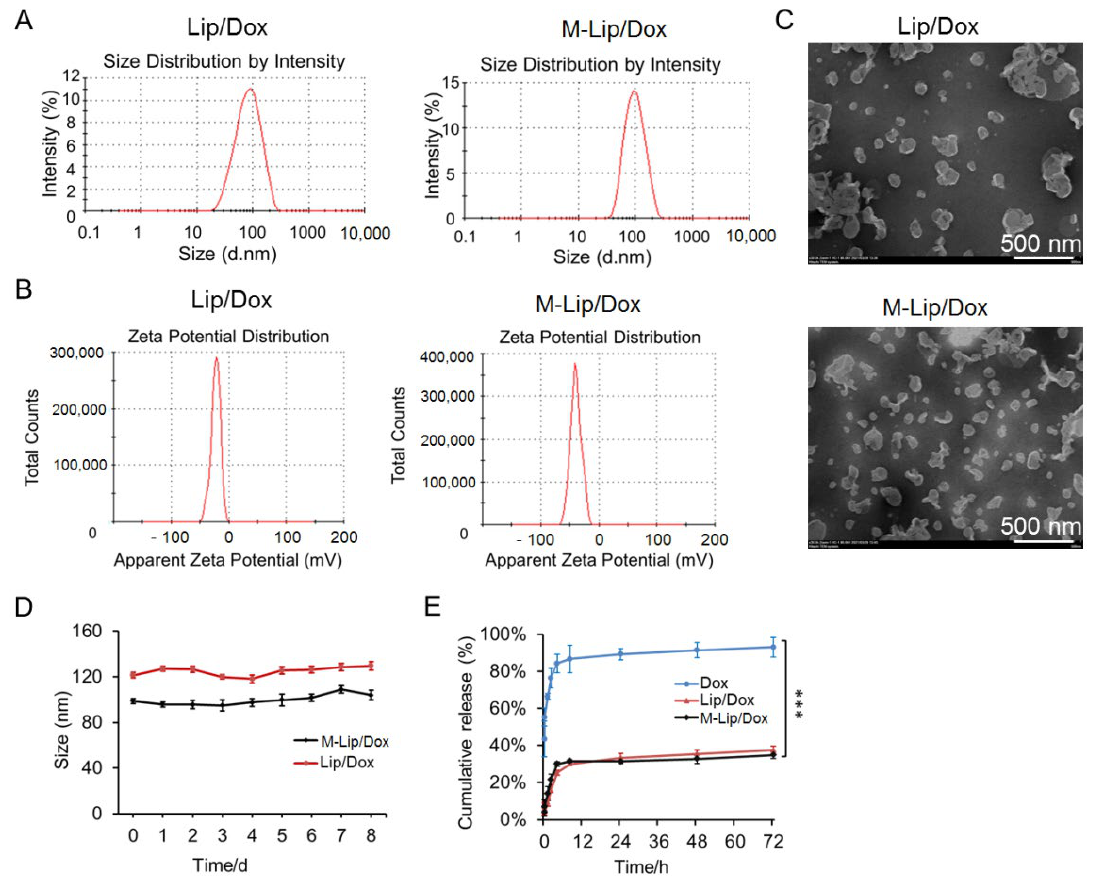
Figure 1. In vitro characterization of ordinary Dox loaded liposomes (Lip/Dox) and maleimide-functionalized Dox loaded liposomes (M-Lip/Dox). ( A ) Particle size distribution. ( B ) Zeta potential distribution. ( C ) Transmission electron micrographs. ( D ) Change in particle size during storage at 4 °C for one week. ( E ) In vitro release profiles of free Dox, Lip/Dox, and M-Lip/Dox at pH 6.8. Data are shown as mean ± SD (n = 3). *** p < 0.01.